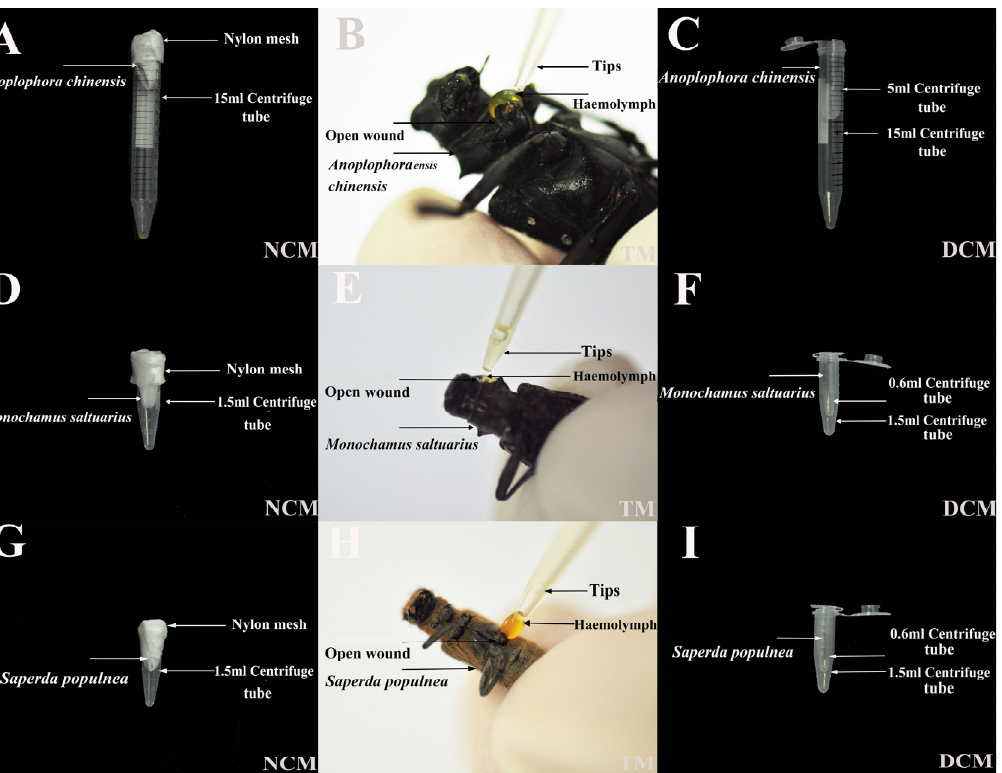
Figure 2. Overview of three methods used to extract haemolymph from adult cerambycid beetles. ( A , D , G ): net centrifugation method (NCM); ( B , E , H ): tearing method (TM); ( C , F , I ): double centrifugation method (DCM).